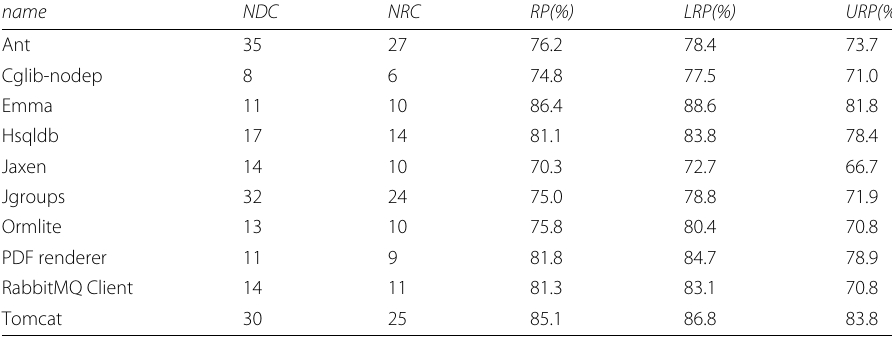
Table 4 Results of disturbing-recovering experiment